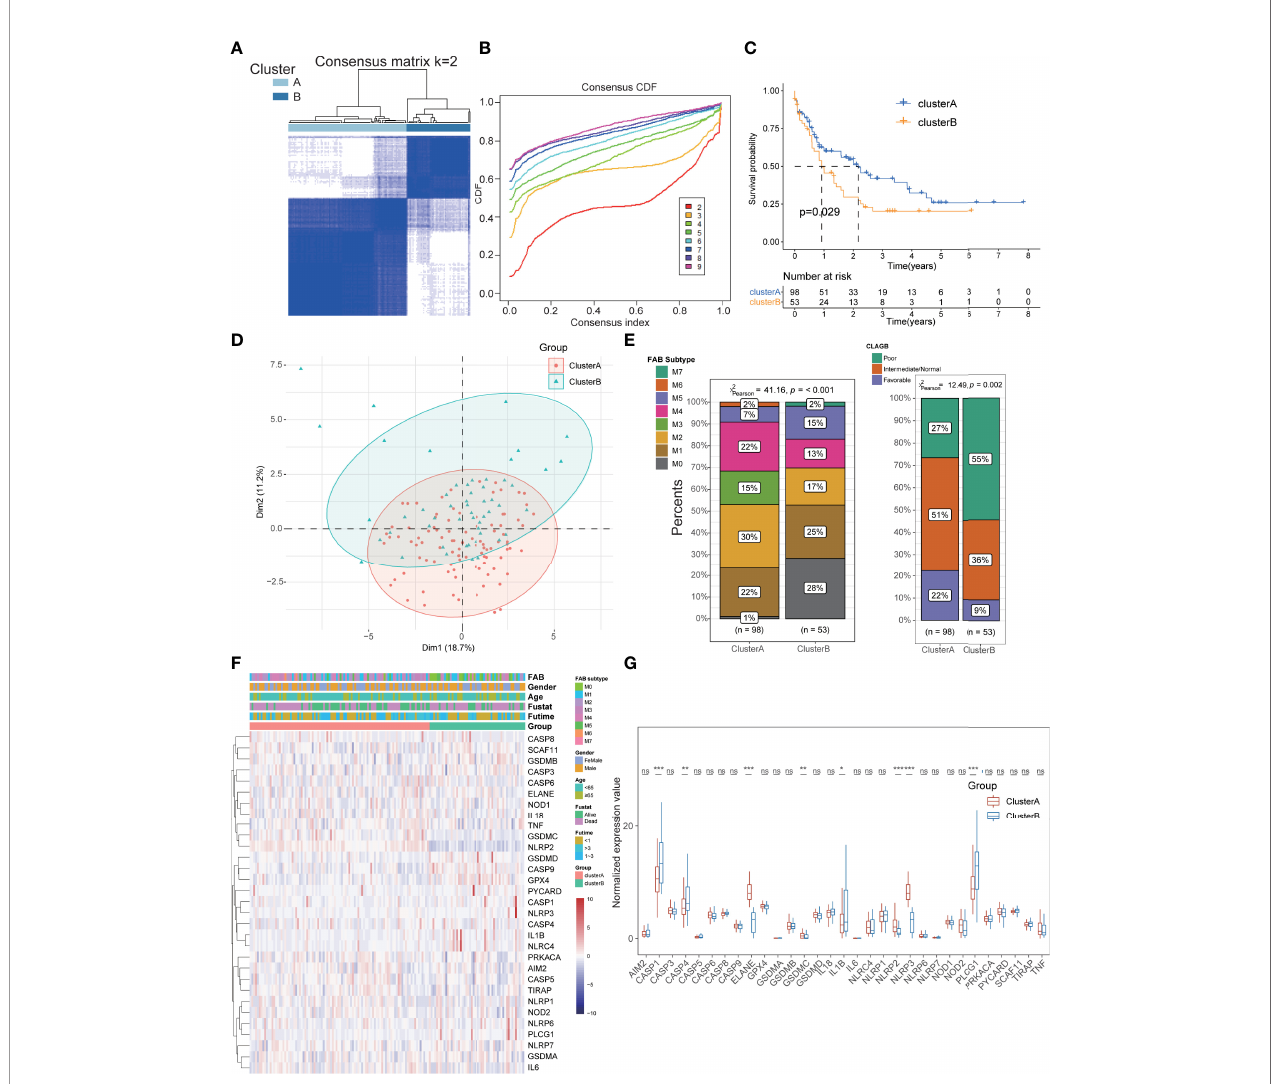
FIGURE 3 | Identi fi cation of pyroptosis-related subtypes and clinical features in AML. (A, B) The cases could be well grouped into two clusters. (C) The survival analysis exhibited a better prognosis in cluster A than that in cluster B groups . (D) PCA showing signi fi cant differences in the pyroptosis-related transcription pro fi les between two clusters . (E) Cluster A patients manifested signi fi cant association with benign clinical characteristics than cluster B patients. (F, G) Comparison of the expression levels of these PRGs between two subgroups. *P<0.05, **P<0.01, ***P<0.001; ns, not signi fi